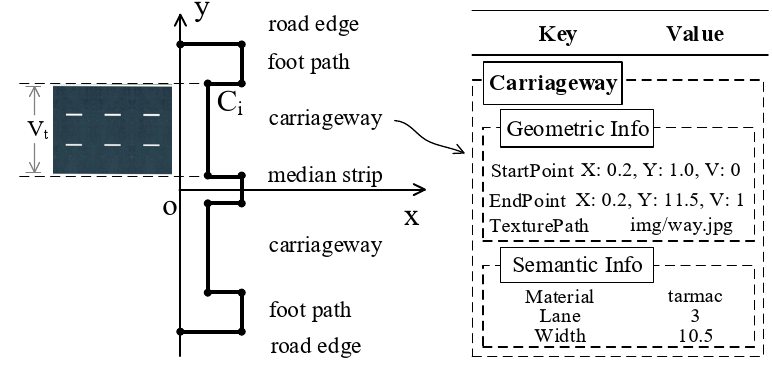
Figure 5. Roadbed template.